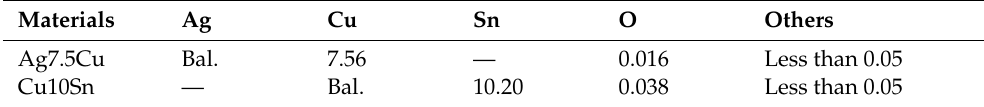
Table 1. Chemical compositions of Ag7.5Cu and Cu10Sn alloy powders (wt.%).